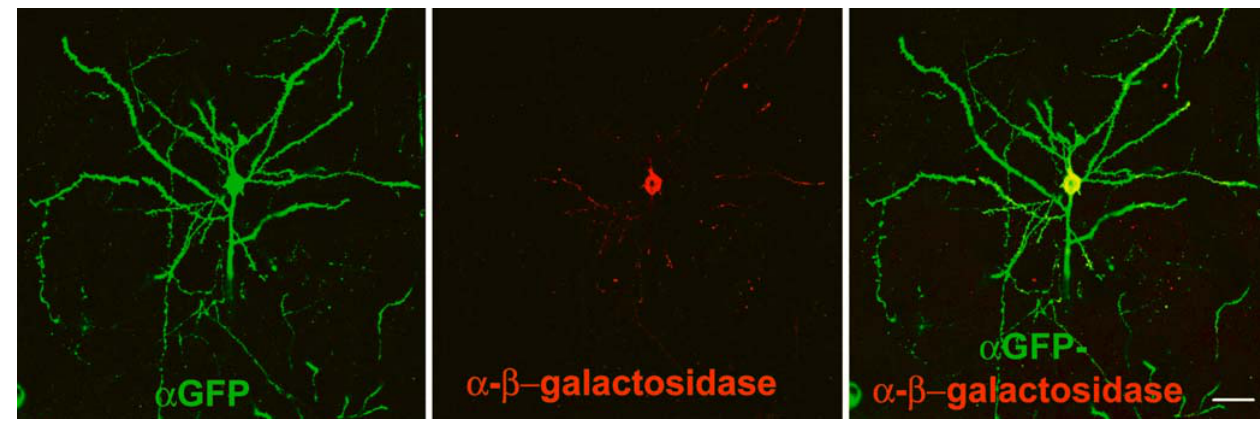
Figure 5. Multiple transgenes can be expressed in the same cell. As determined by confocal microscopy, the resulting R26R + TLG 498 + Cre 3487 + offspring express both EGFP-F (green) and b -galactosidase (red) in a Cre-dependent fashion. b -Galactosidase is predominantly localized perinuclearly and partly in the dendrites whereas EGFP-F labels the entire neuron. Scale bar: B 2 25 m m.